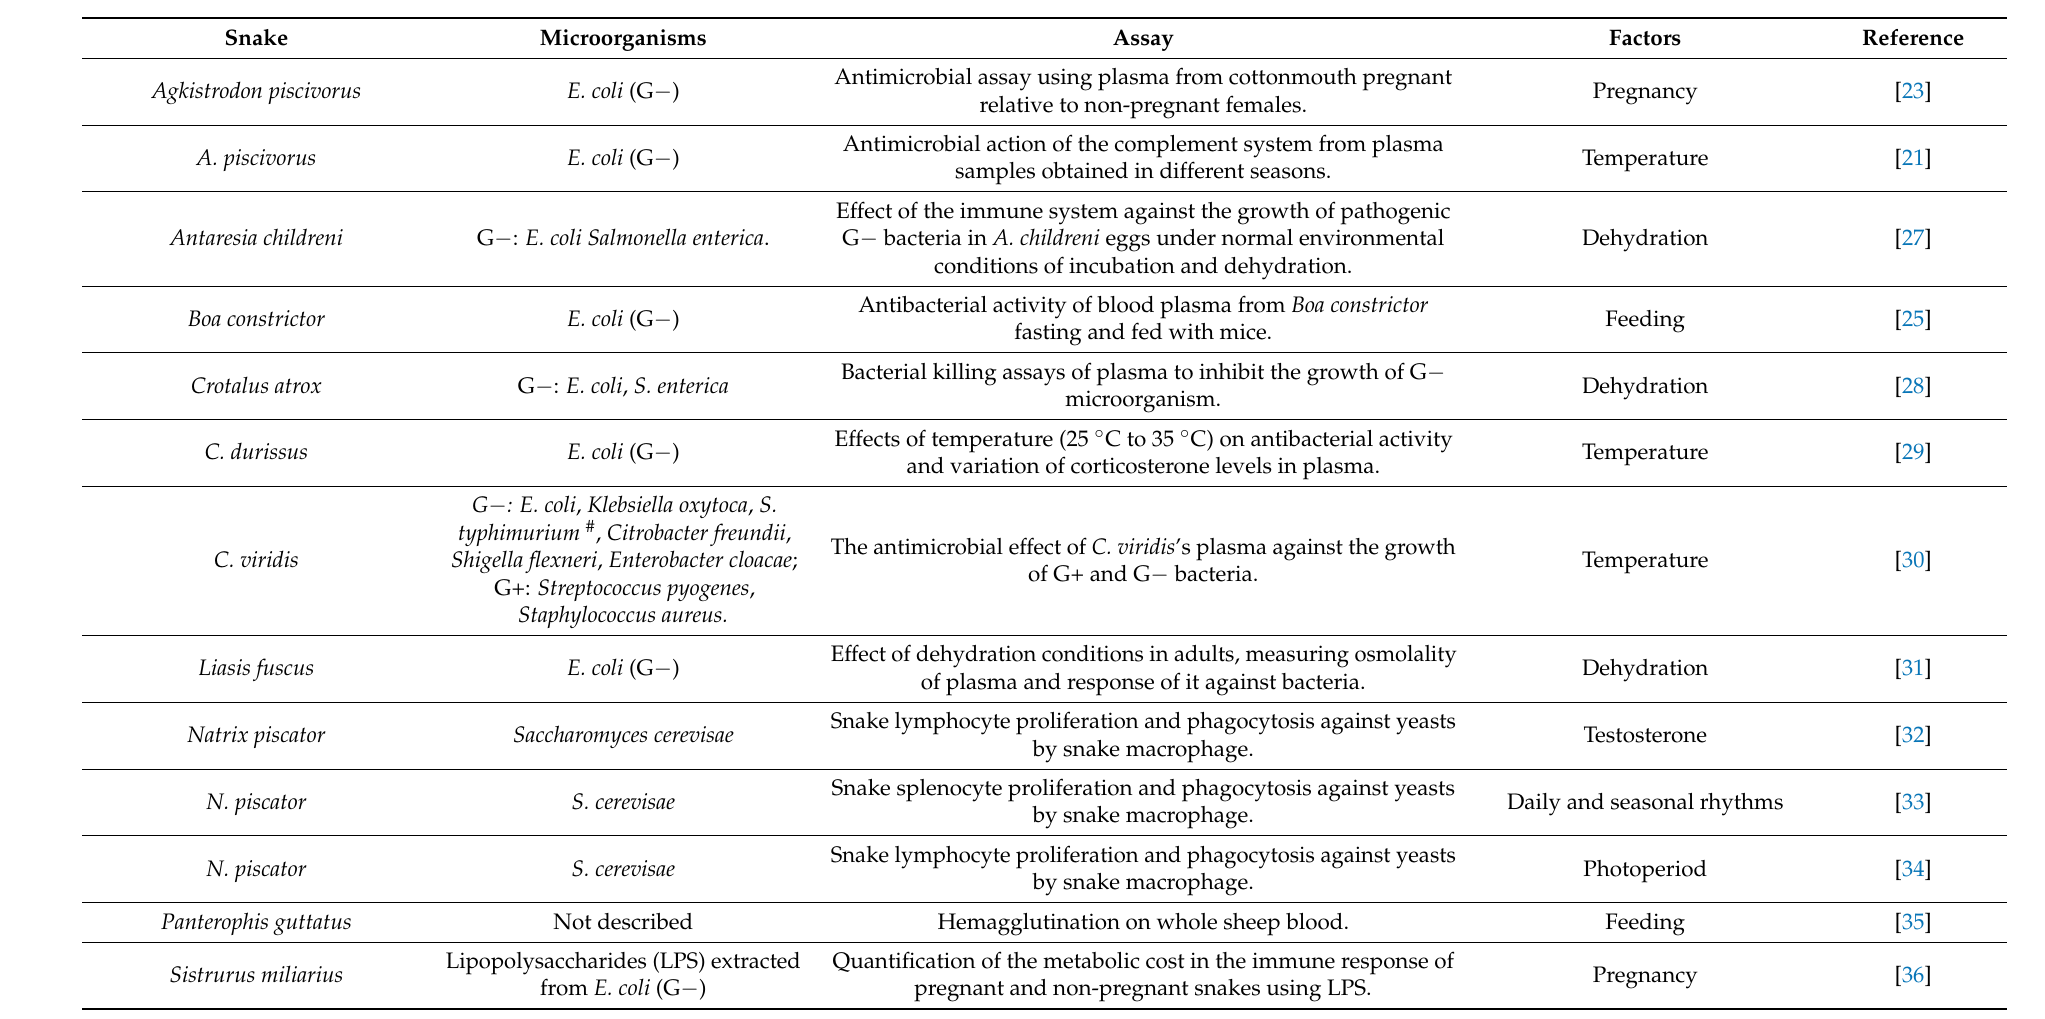
Table 1. Plasma innate immunity and association to environmental and physiological conditions. Snake Assay Antimicrobial assay using plasma from cottonmouth pregnant relative to non-pregnant females. Antimicrobial action of the complement system from plasma samples obtained in different seasons.